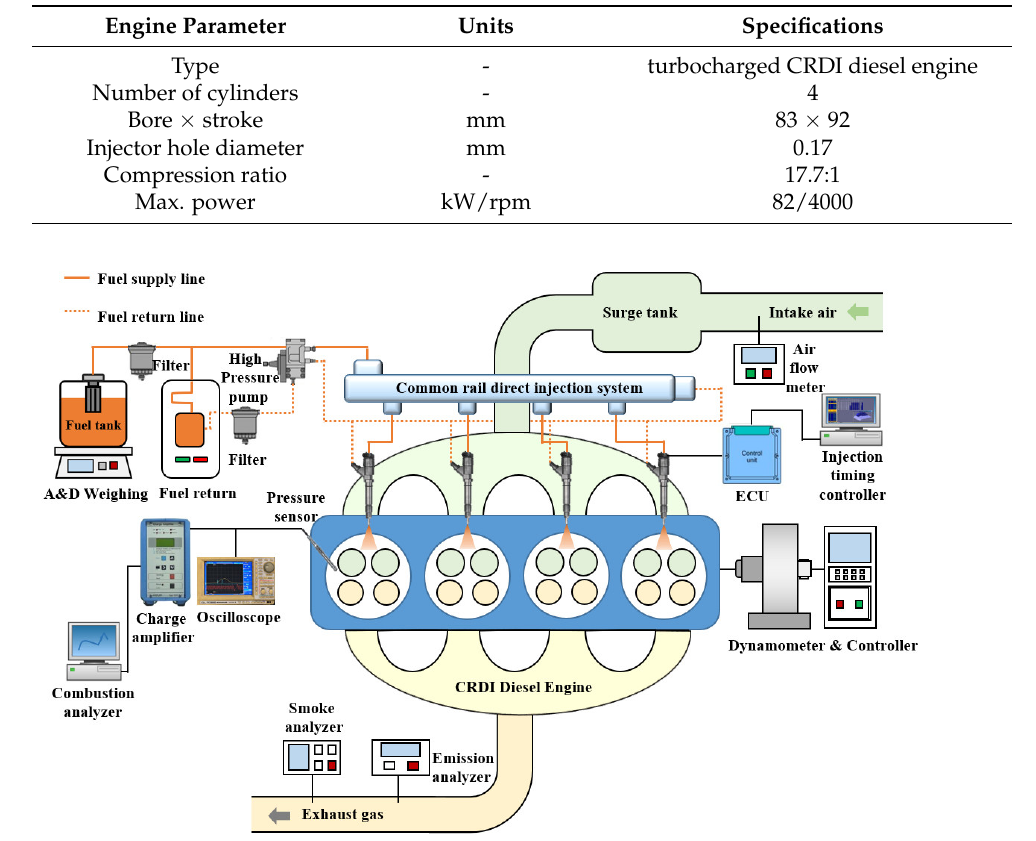
Figure 1. Schematic diagram of the experimental apparatus. Table 3. Experimental and operating conditions.